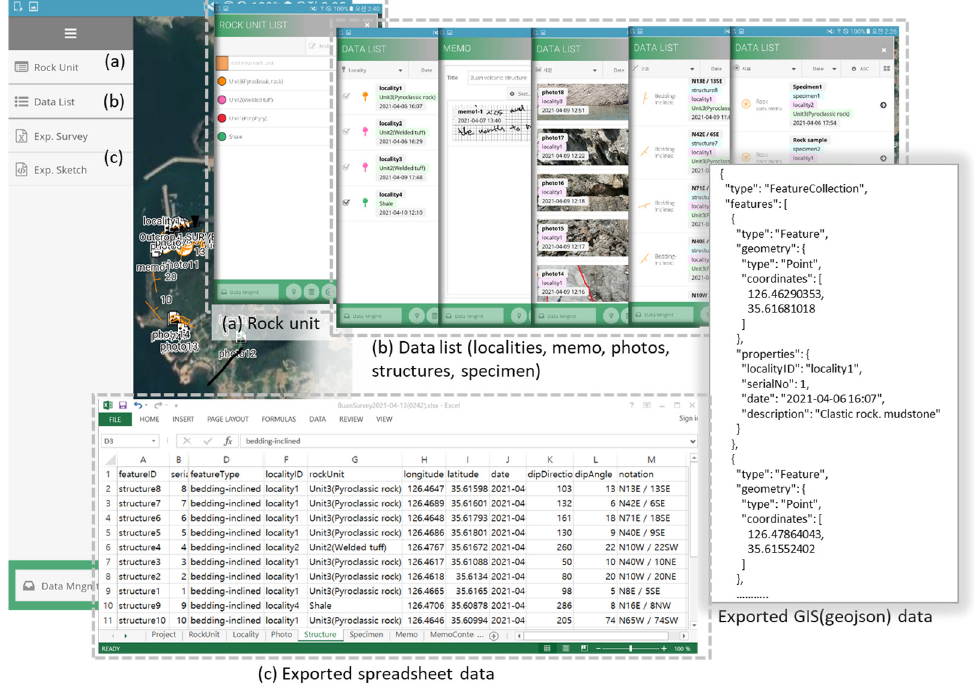
Figure 7. Data management tools: ( a ) rock units, ( b ) data list, and ( c ) exporting results as spreadsheet or GIS data.